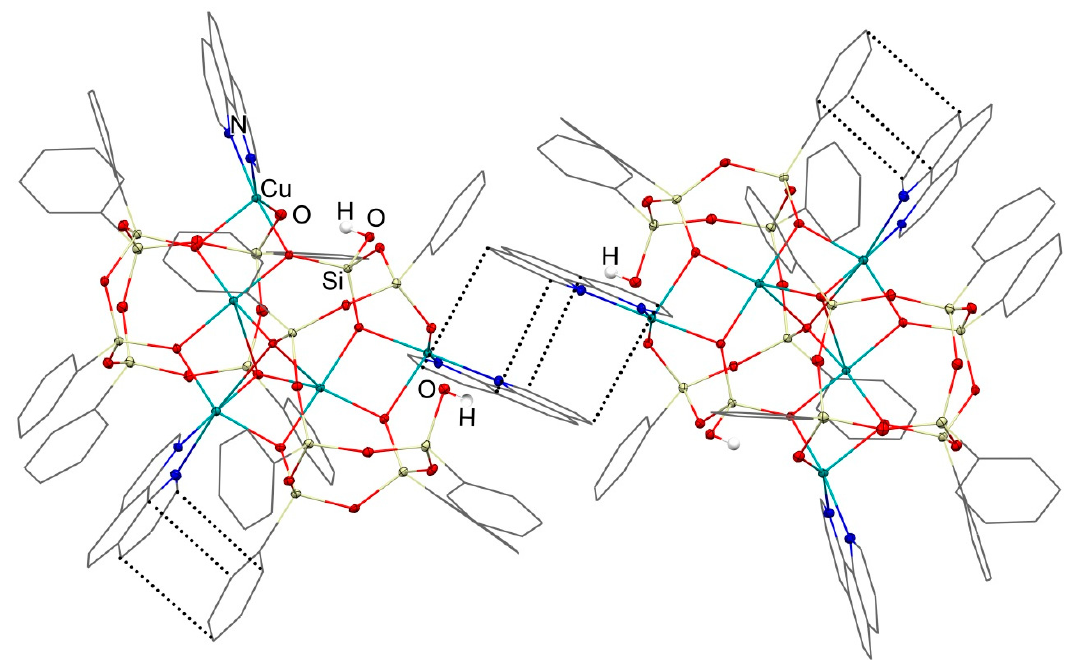
Figure 4. Top. “Phenanthroline to phenanthroline” stacking interactions of 1 in crystal. Bottom. “Phenanthroline to phenanthroline” and “Phenanthroline to phenyl” stacking interactions of 2 in crystal.